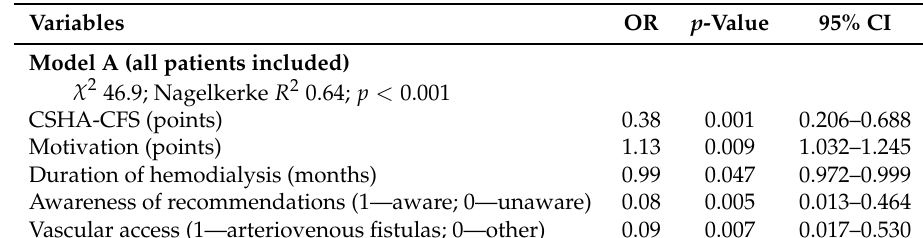
Table 5. Multivariate logistic regression analysis—factors significantly associated with adherence to physical activity